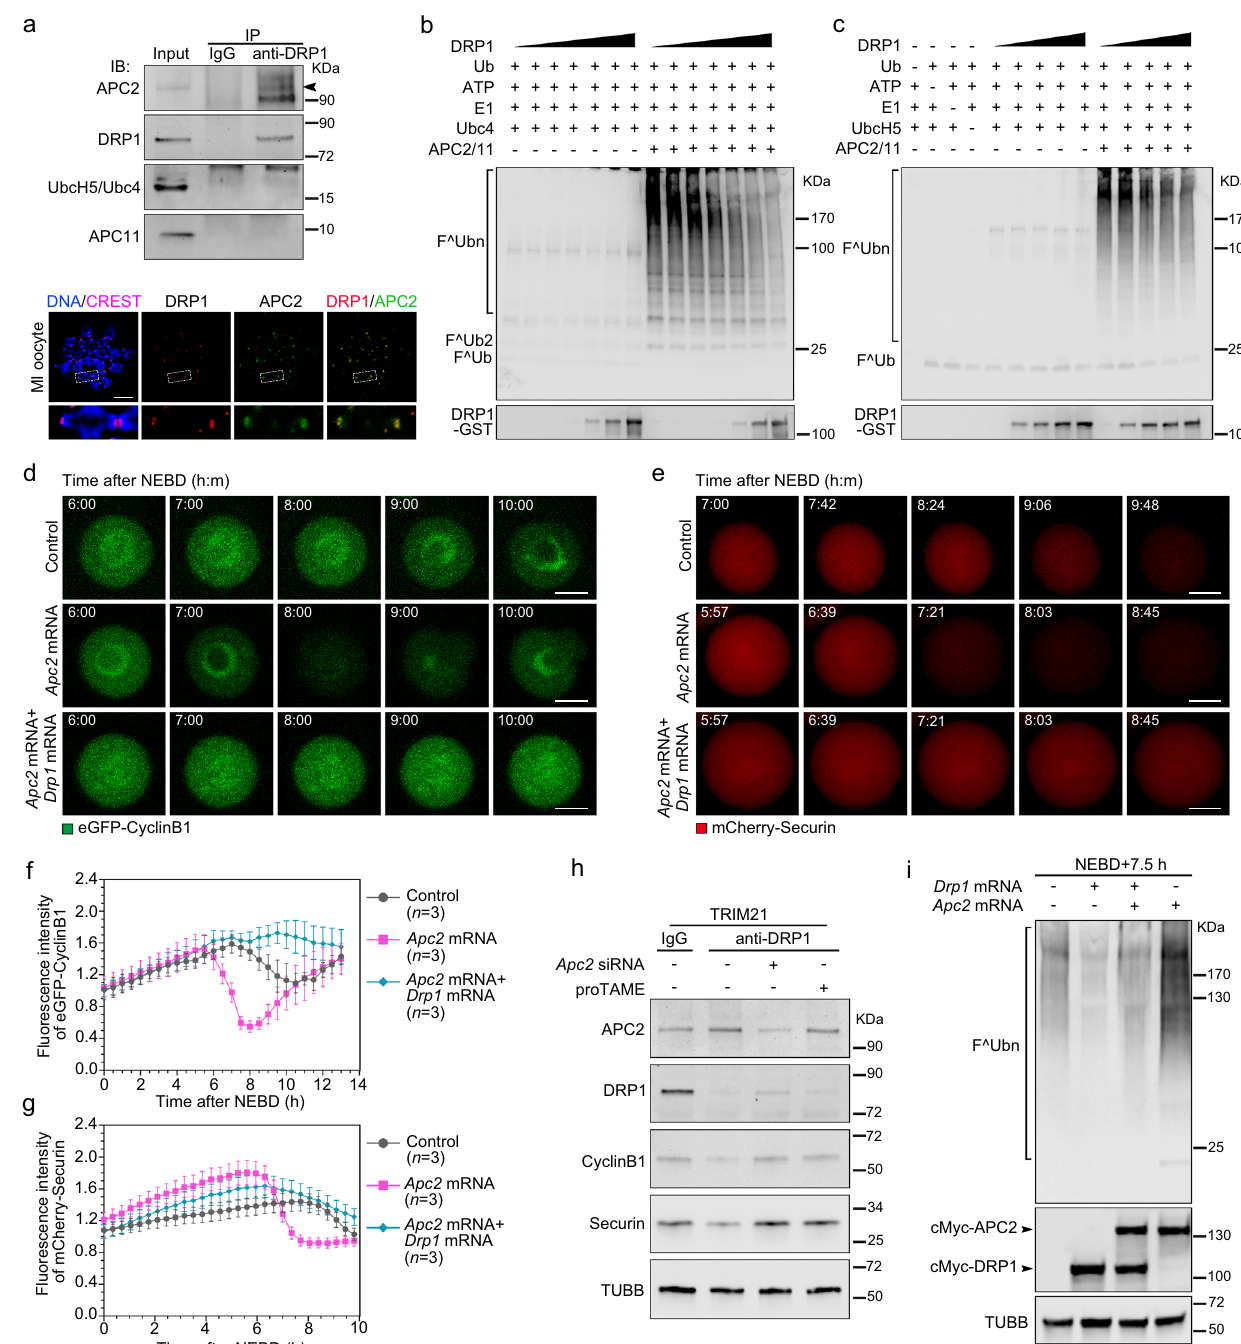
sixteen-colour image was used to show the bands in visible. Original blots can be found in the Source Data fi